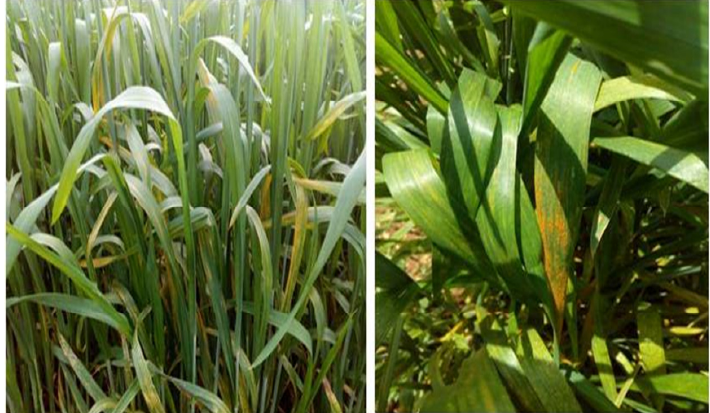
Fig. 3. Stripe rust symptoms observed on soft wheat cultivar ‘Arrehane’ during the growing season 2017-2018 at the experimental field (ENAM, Meknes,